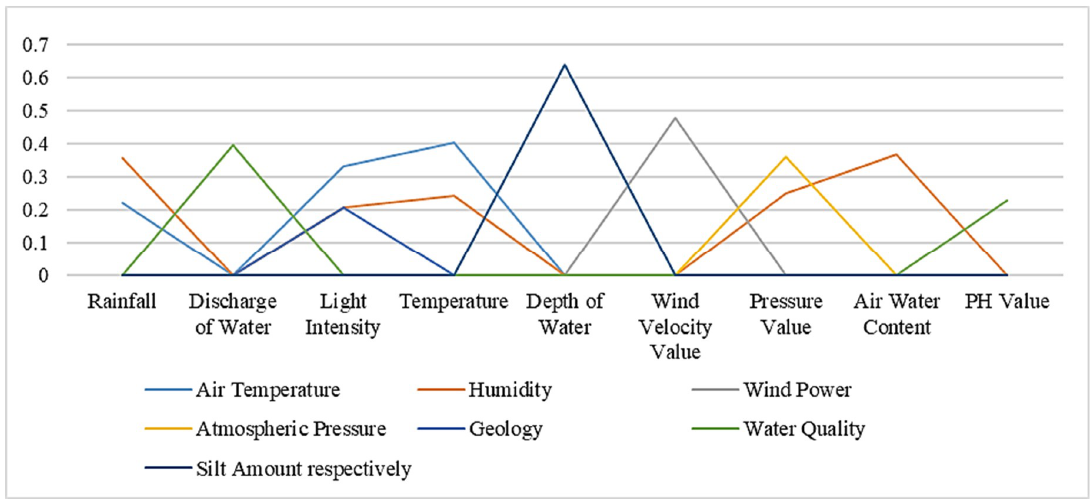
Figure 5. Similarity results based on analytic hierarchy process (AHP). Table 8. Similarity results based on structural strategy.